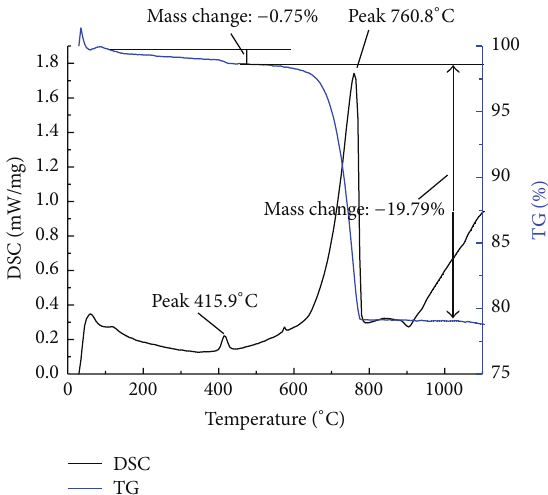
Figure 19: Thermal analysis spectrum of CF.